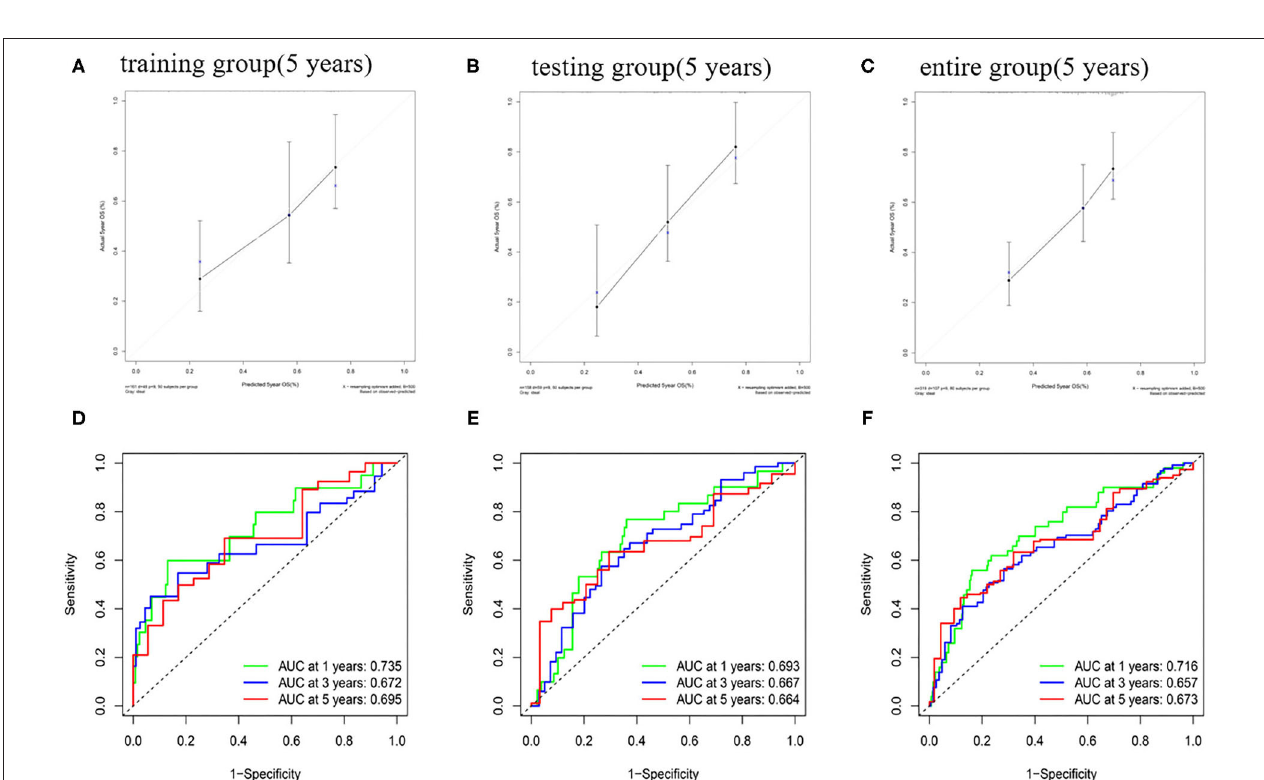
FIGURE 8 | The calibration curve of OS and ROC curve in the training group (A,D) , testing group (B,E) , and entire group (C,F) .